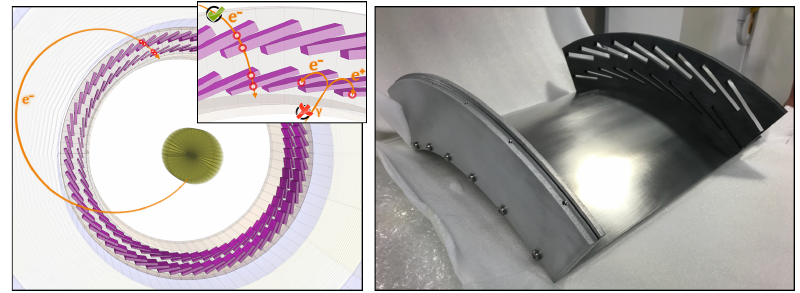
Figure 4. Left: Positioning of CTH counters inside CyDet. The inset demonstrates the required four- fold coincidence. Right: Impression of a section of the full-sized CTH prototype holding